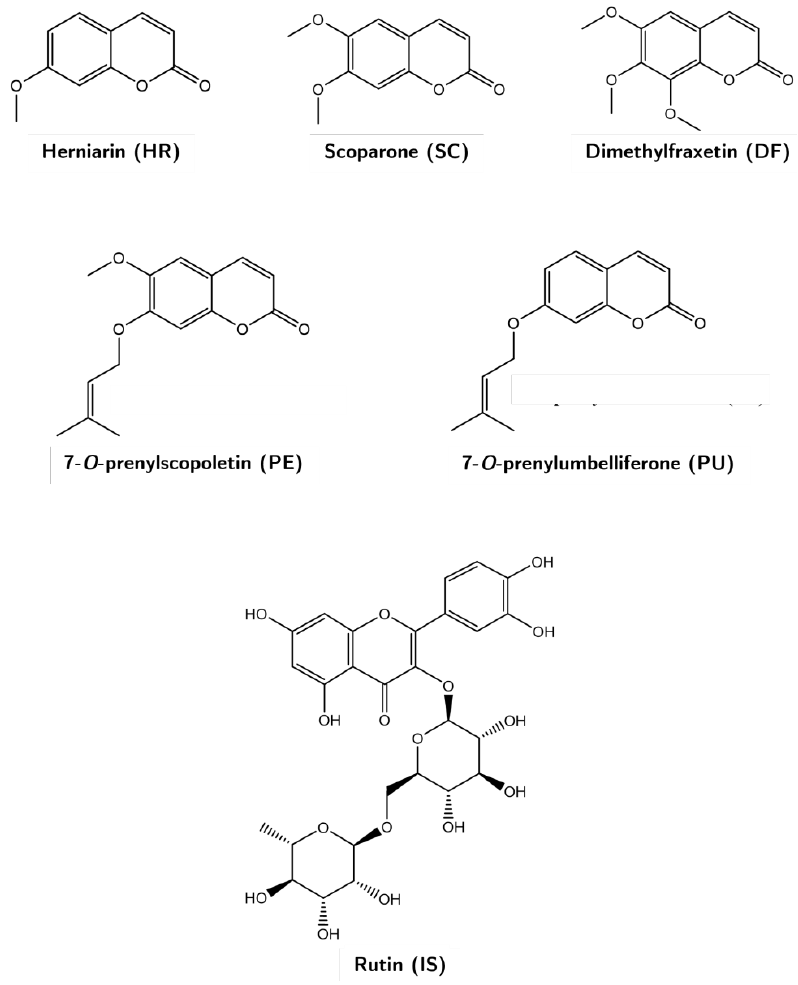
Figure 5. Chemical structures of the coumarins 7- O -prenylscopoletin (PE), scoparone (SC), dimethylfraxetin (DF), herniarin (HR), and 7-O-prenylumbelliferone (PU), and of the rutin (IS).